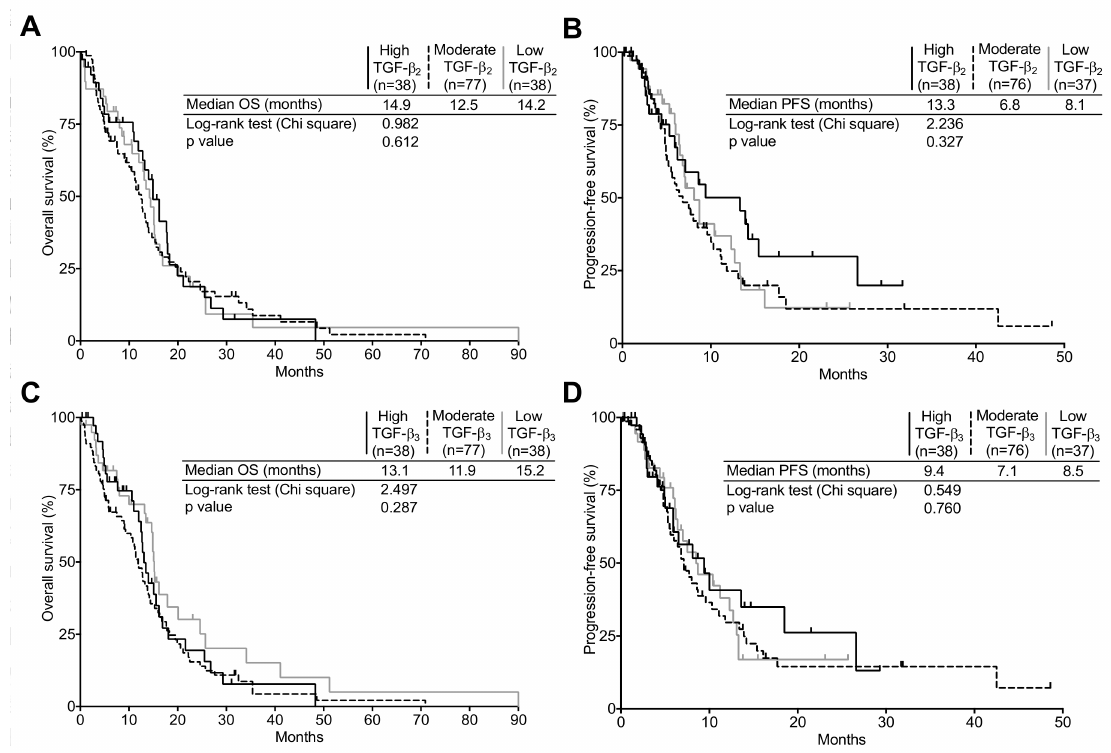
Figure 2. Correlation of TGF- β 1 and - β 3 mRNA expression with survival in the TCGA cohort. ( A , B ) Kaplan–Meier estimates of overall survival and progression-free survival according to three subgroups of TGF- β 2 or ( C , D ) TGF- β 3 expression (high, black line; moderate, dashed line; low, gray line). The progression-free survival data was unavailable for two